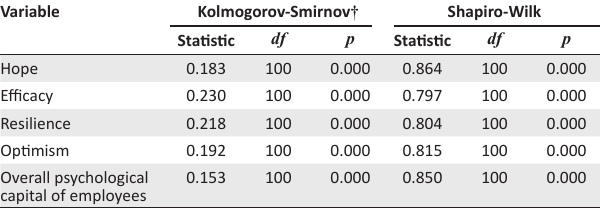
TABLE 16: Test of normality of psychological capital variables. Variable Kolmogorov-Smirnov